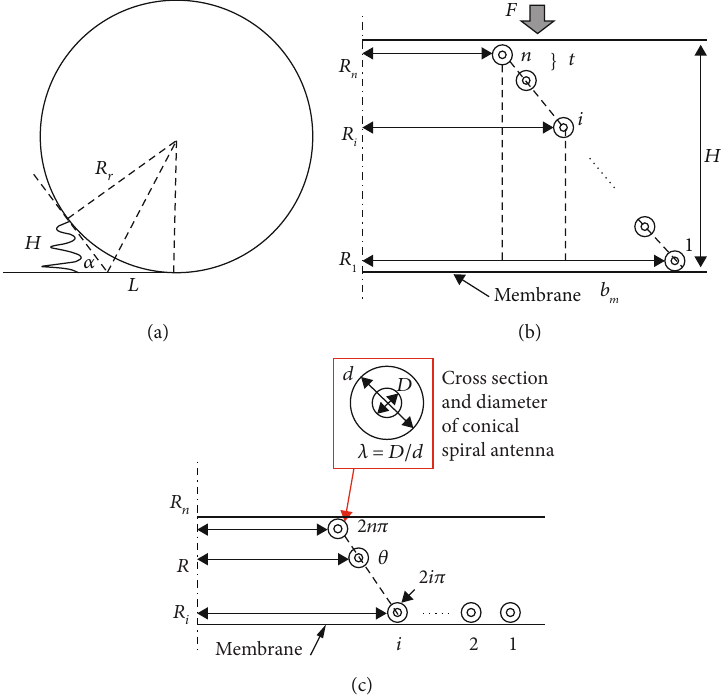
Figure 2: (a) Geometric relationship between scroll and conical spiral antenna. (b) Cross section of conical spiral antenna at the initial state. (c) Cross section of conical spiral antenna under partial compression.